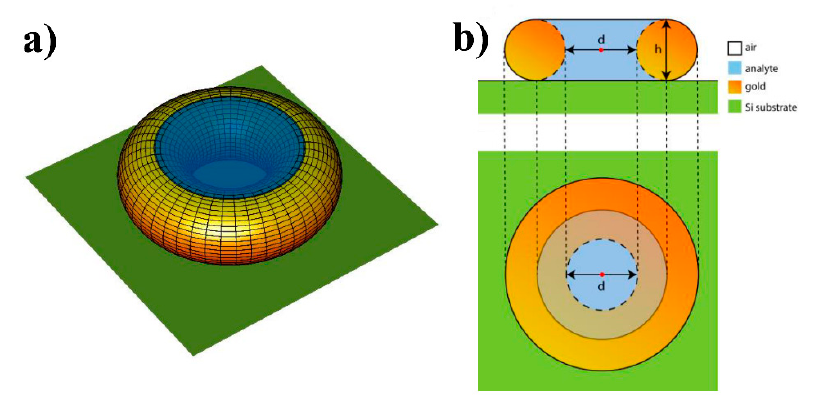
Figure 5. Schematic representation of the gold torus ( a ) showing the cross-sectional circles and planar section ( b ). The red dot in the middle of the torus in ( b ) denotes the coordinate where the electric field of incident plane wave is calculated.